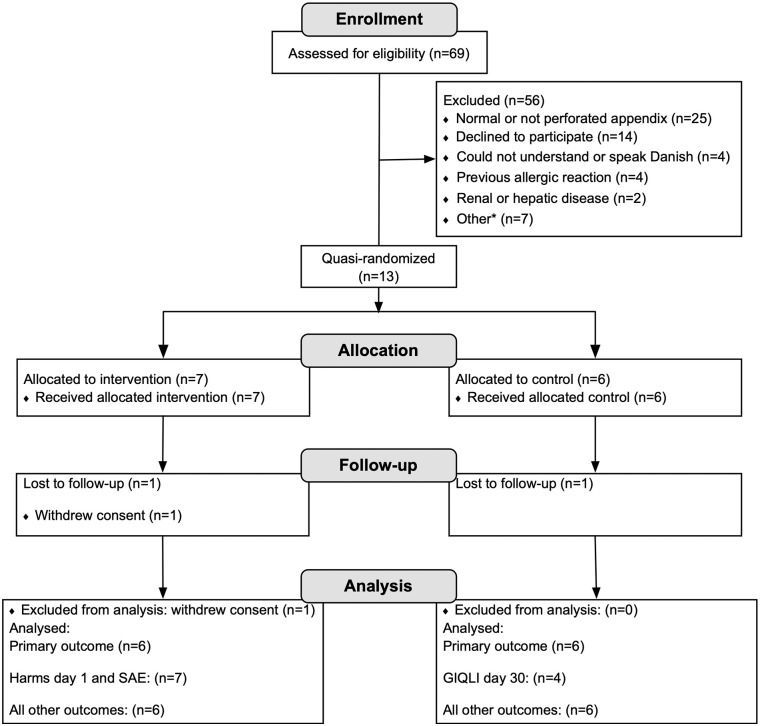
Flowchart of the screened, enrolled, allocated, and analyzed patients in the trial. *Other reasons for exclusion (n): breastfeeding (1), hematological disease (1), other intra-abdominal disease requiring surgical intervention (1), administration of intravenous metronidazole prior to surgery (intervention group, 1), other unspecified (2), logistic circumstances (1). SAE, serious adverse event.